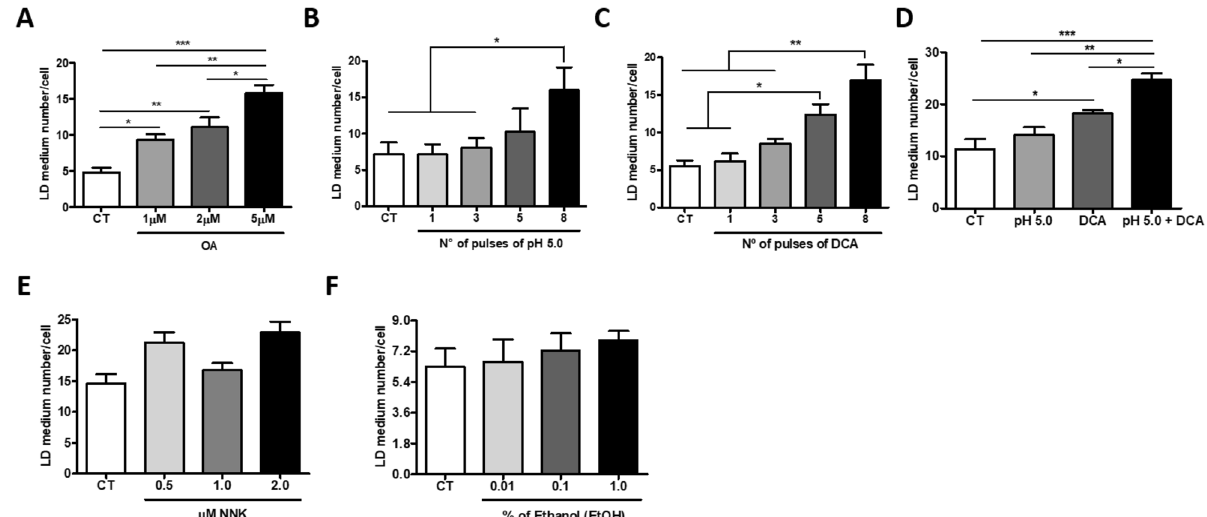
Figure 2. Lipid droplets (LD) number evaluation in the normal immortalized esophageal cell line, Het1a, upon exposure to esophageal tumors risk factors associated stimuli. LD quantification assessed by Oil Red O (ORO) staining following Het1a incubation with 1 µM, 2 µM or 5 µM of Oleic Acid (OA) for 24 h ( A ); Het1a stimulation with increasing number of acidified medium (pH5.0) ( B ), or 200 µM Deoxycholic Acid (DCA) ( C ) 3 min pulses, or the combination of both ( D ); Het1a treated with increasing concentrations of NNK (Nicotine- derived nitrosamine ketone) ( E ) and ethanol ( F ) for 24 h. Experiments were performed in triplicate *p < 0.05; **p < 0.005; ***p <